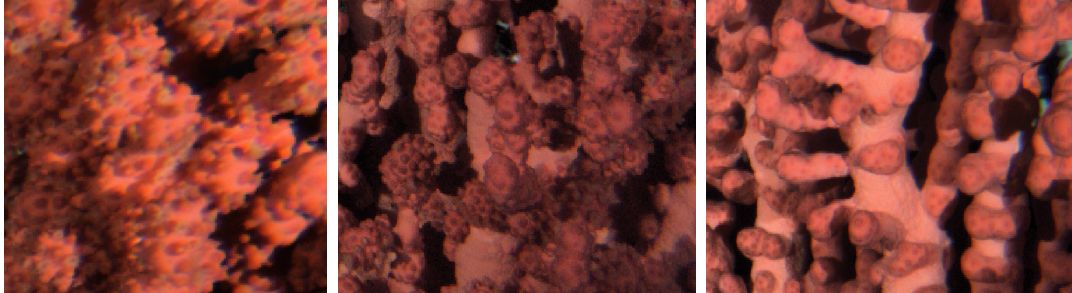
Figure 4. Different activity statuses of the coral as bloated ( left ), semi-bloated ( middle ) and non-bloated ( right ) for comparison. Those types of rectangular enlargements were selected in each image for the manual tagging of the behavioral status when establishing the training set.